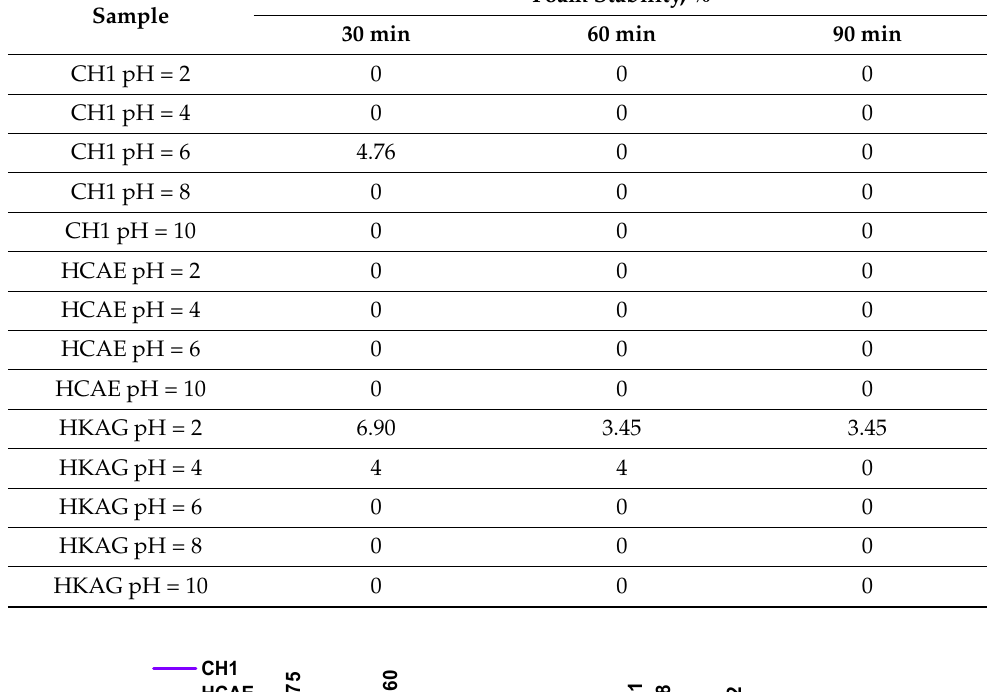
The ATR ‐ FTIR spectroscopy analysis results are presented in Figure 6.